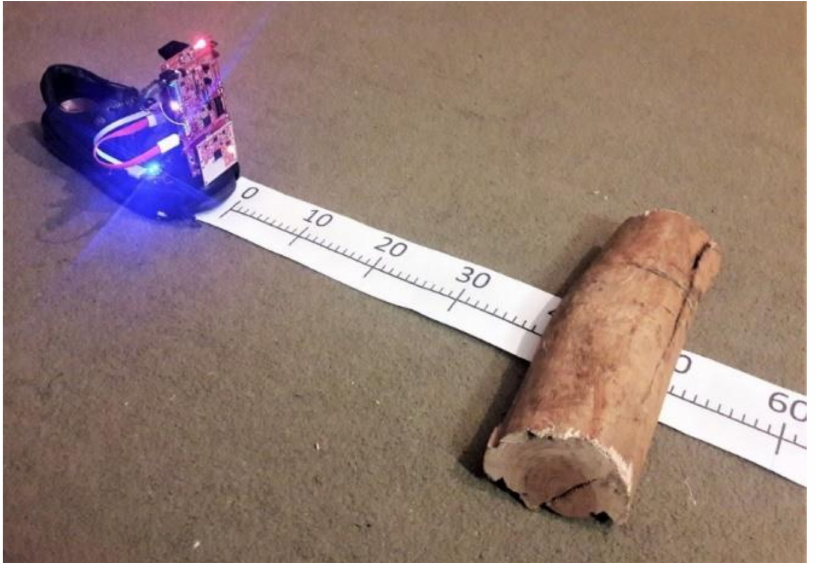
Figure 8. Experimental setup. A wooden obstacle was placed at different distances from the smart shoe prototype to characterize the radar sensor accuracy and detection capacity. The log was placed on the 70 cm mark and then the smart shoe data-logger was started. 0 cm in 10 cm steps, modifying its position every 10 s